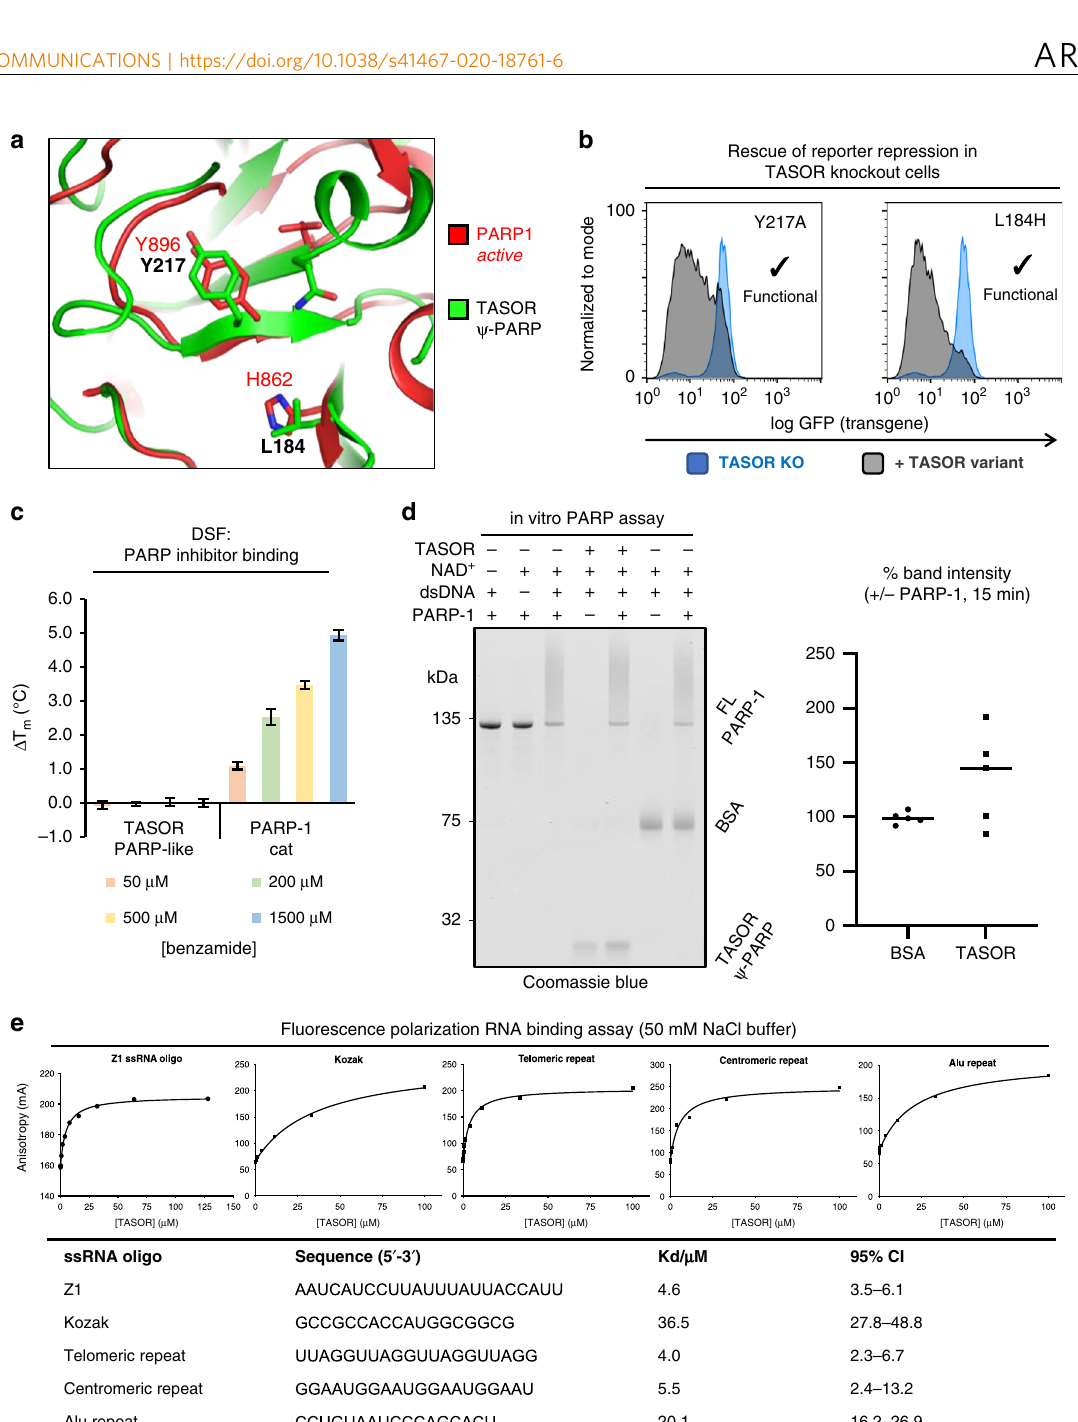
performed a gel-based poly-ADP-ribosylation (PARylation) assay by mixing recombinant full-length human PARP-1 with the TASOR PARP domain or negative control BSA. While PARP-1 robustly auto-PARylated in the presence of NAD + and dsDNA, shown by a high molecular weight smear in the Coomassie-stained gel, we did not detect signi fi cant evidence of TASOR modi fi cation